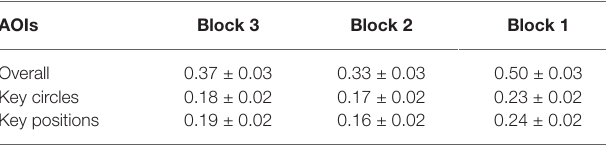
TABLE 1 | Descriptive statistics of fixation ratio in AOIs (M ± SD). AOIs